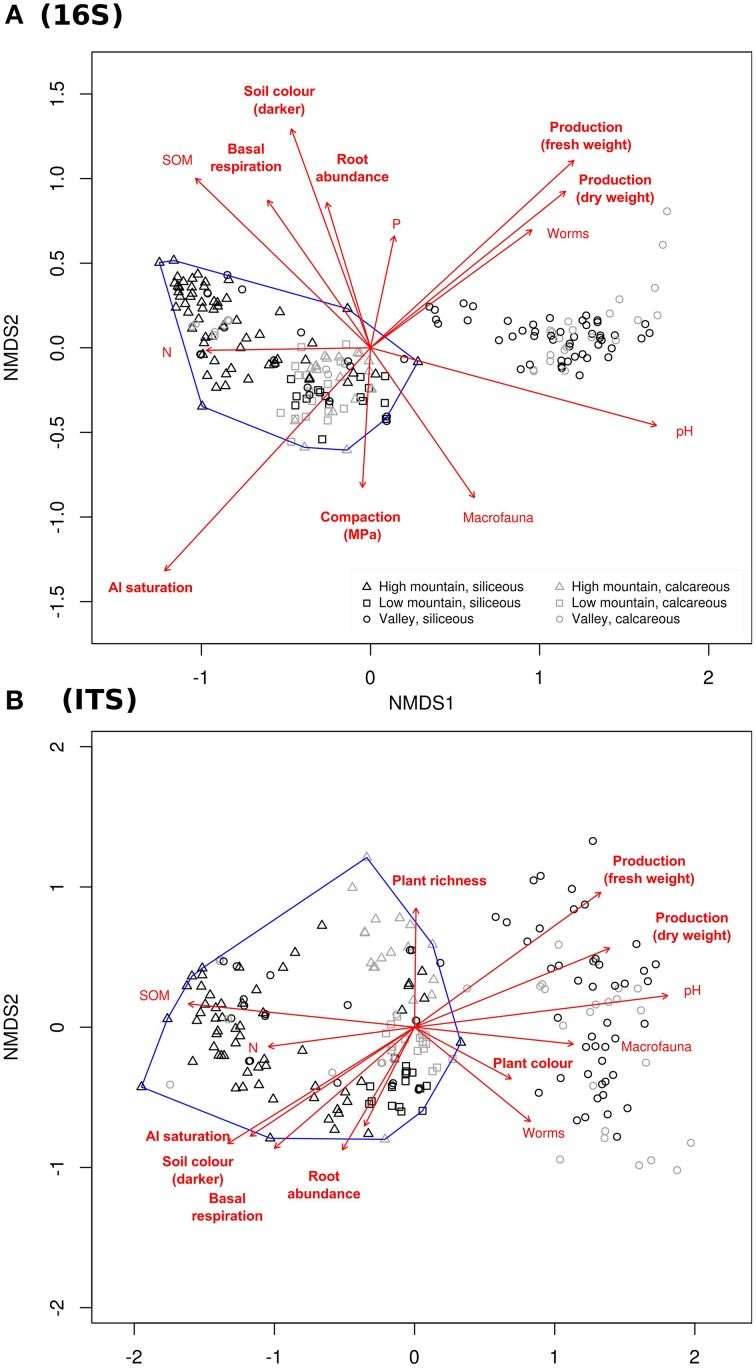
Non-metric multidimensional scaling (NMDS) based on Bray-Curtis dissimilarities of community composition. Composition was based on relative OTU abundances from (A) prokaryotic 16S and (B) fungal ITS amplicon data. Sites are labeled according to legend and the area containing all mountain sites is enclosed by blue lines. Red vectors indicate fitted environmental parameters significantly correlated to NMDS coordinates.